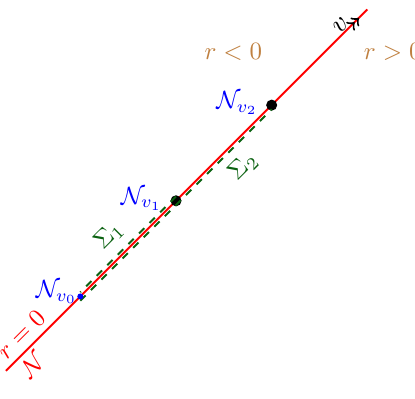
Figure 5 . Null boundary N and segments Σ 1 , Σ 2 on